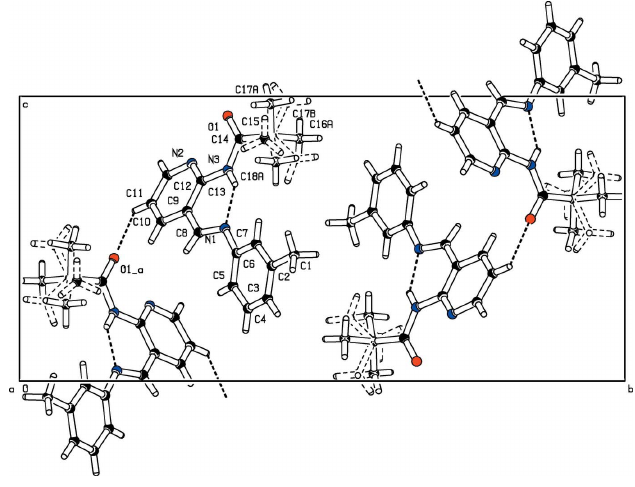
Figure 2 The packing, viewed down [100], showing the hydrogen-bonding interactions (dashed lines).